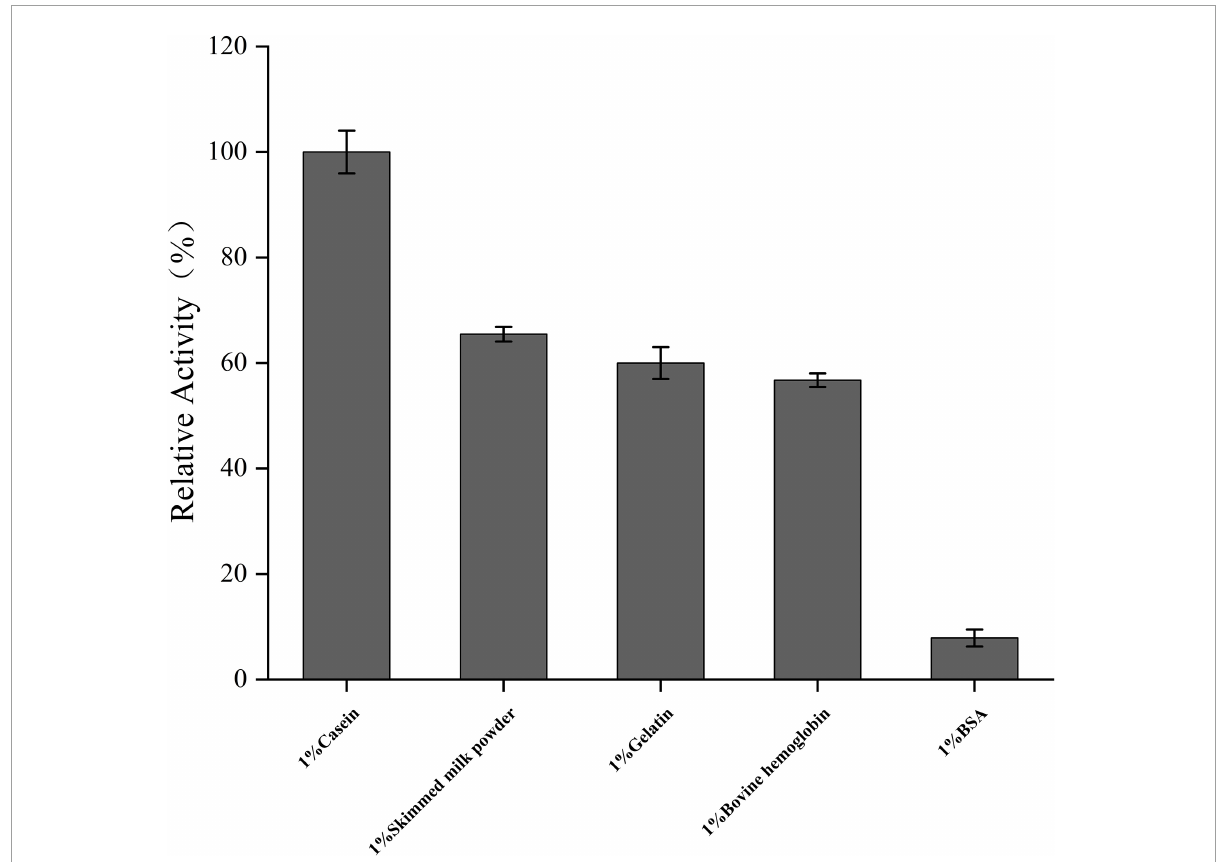
FIGURE7 Analysis of substrate-dependent protease activity. Mean values are from three independent